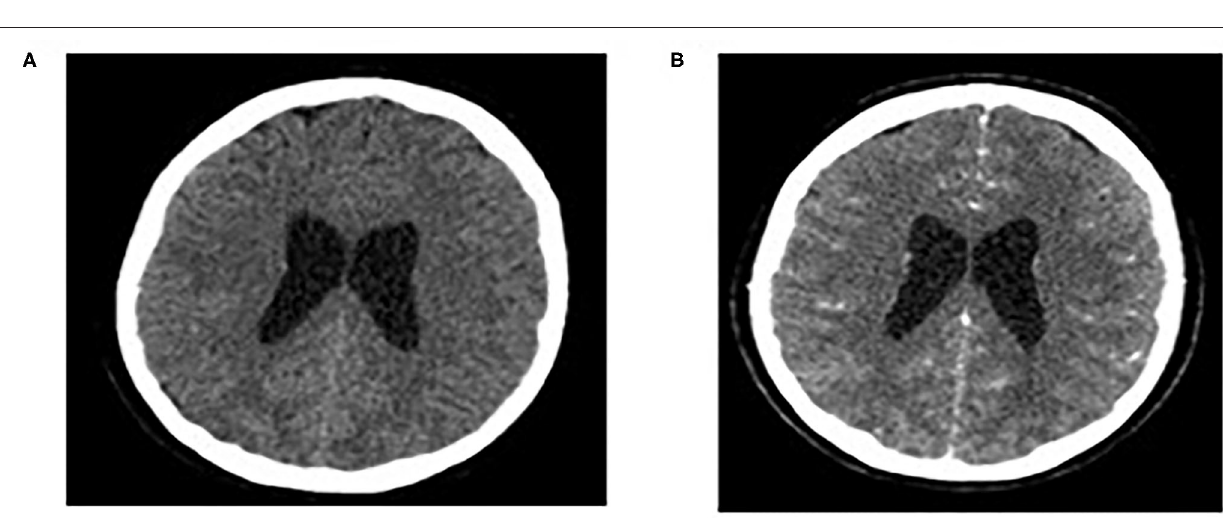
abnormalities, normal cerebrospinal fluid (CSF) composition, elevated lumbar puncture opening pressure ( ≥ 280 mm CSF in children) and normal neuroimaging (Friedman DI, et